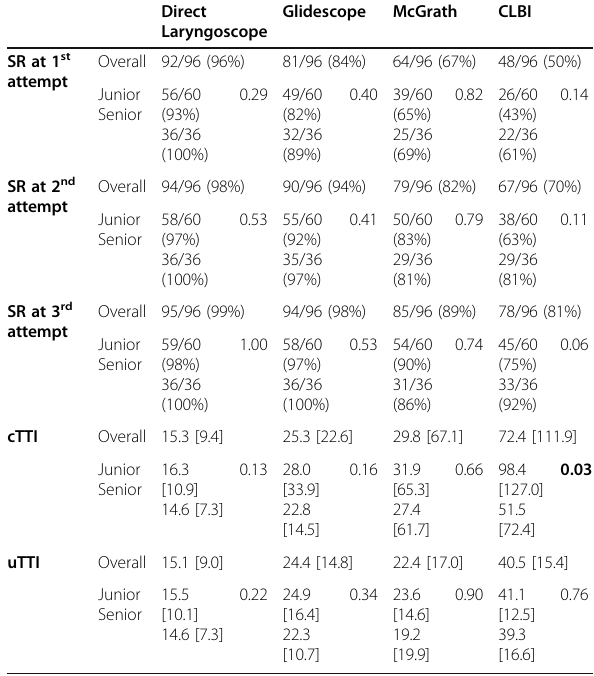
Table 1 (abstract A200). Summary of